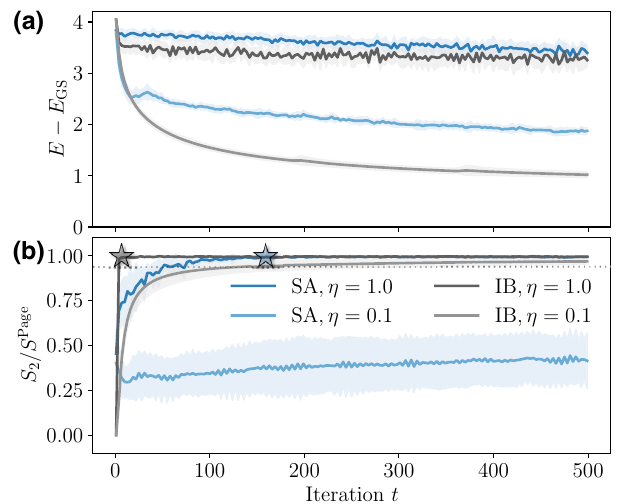
FIG. 7. (a),(b) The application of our algorithm to the problem of finding the ground state of the SYK model. For the initial- ization we consider the small-angle (SA) ( (cid:11) θ = 0.1) and identity block (IB) initialization [12] (using one block). We can see that only through the reset of the learning rate η , as suggested by Algorithm 1, WBPs are avoided during the optimization. The entanglement entropy of the target state is nearly maximal (indi- cated by the dotted line), we omit the WBP line for α = 1 for improved visibility. We measure energy in units of J and use a system size of N = 10, subsystem size k = 2 and a random cir- cuit from Eq. (1) with circuit depth p = 100. Data is averaged over 100 random instances. our algorithm. The tracking of the second Rényi entangle- ment entropy during the optimization reveals that the larger learning rates encounter a WBP while the smaller learning rates successfully avoid